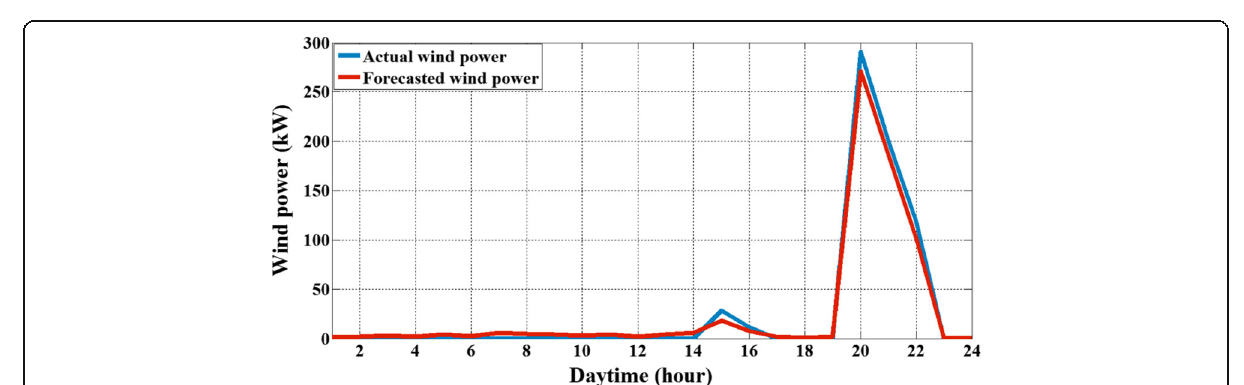
Fig. 5 Actual wind power vs. forecasted wind power for a spring